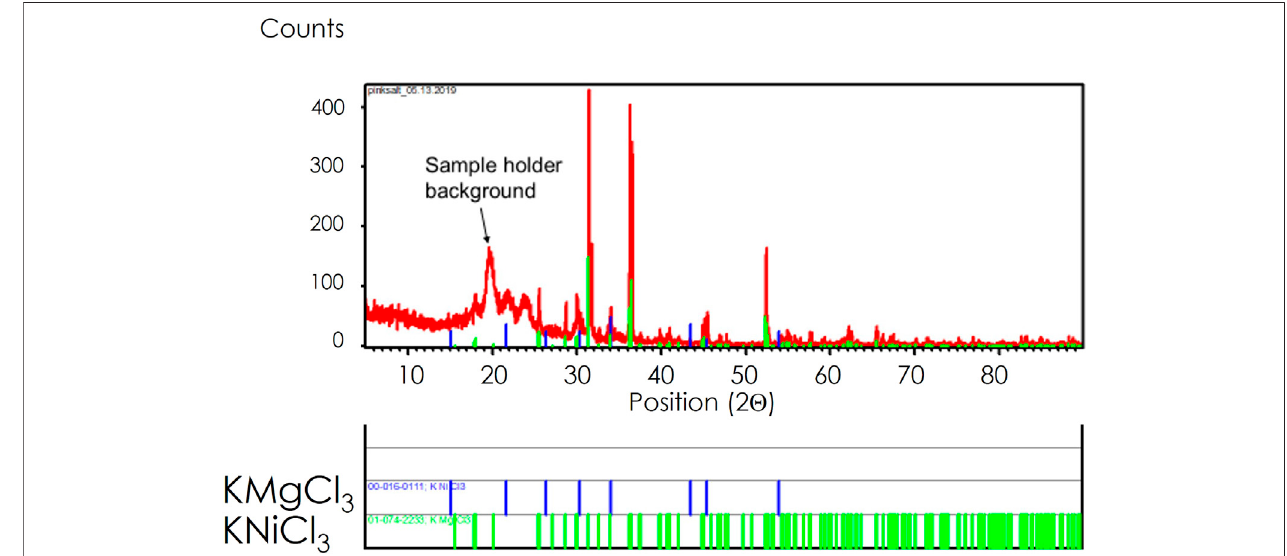
FIGURE 5 | XRD of puri fi ed carnallite, showing mixed chlorides, including a ternary KNiCl 3 compound.